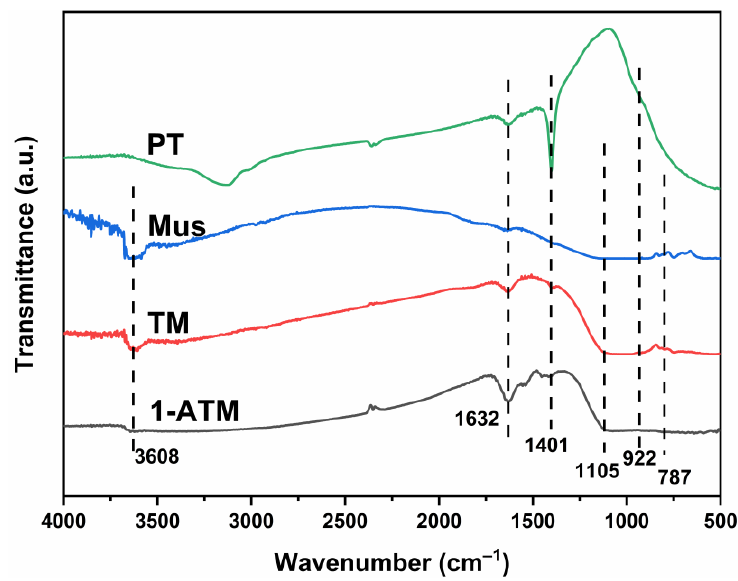
Figure 6. FTIR spectra of PT, Mus, TM and 1-ATM.